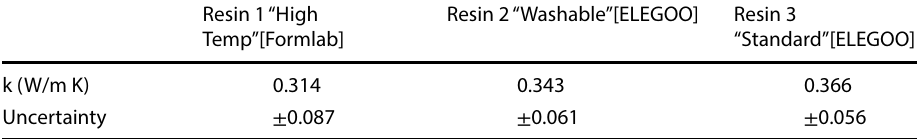
Table 2 Thermal conductivity of each material